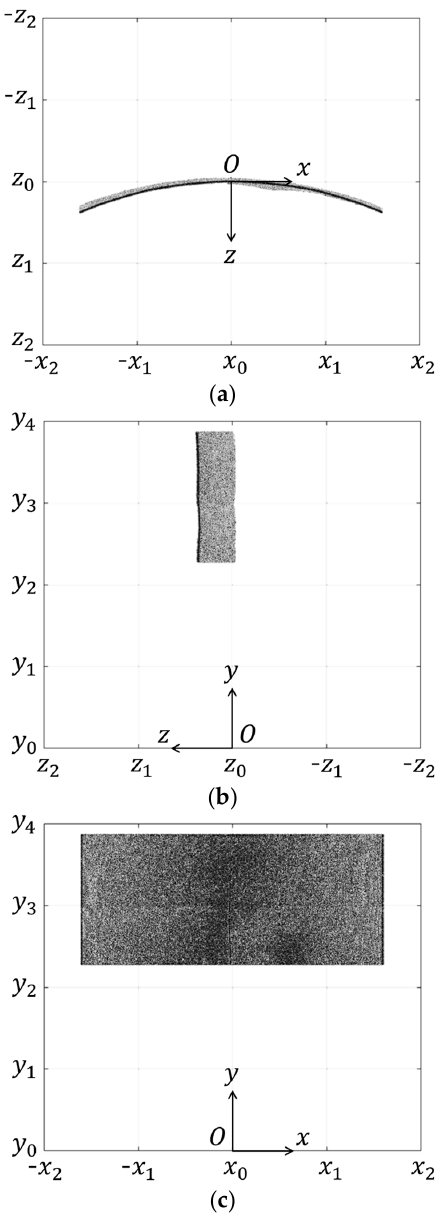
Figure 9. Coordinate ‐ transformed point cloud model in the test target coordinate system: ( a ) Top view; ( b ) Side view; ( c ) Front view.